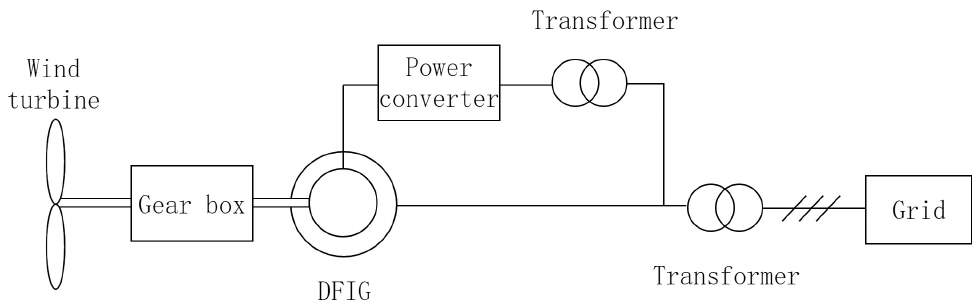
Figure 2. Description of the DFIG wind power